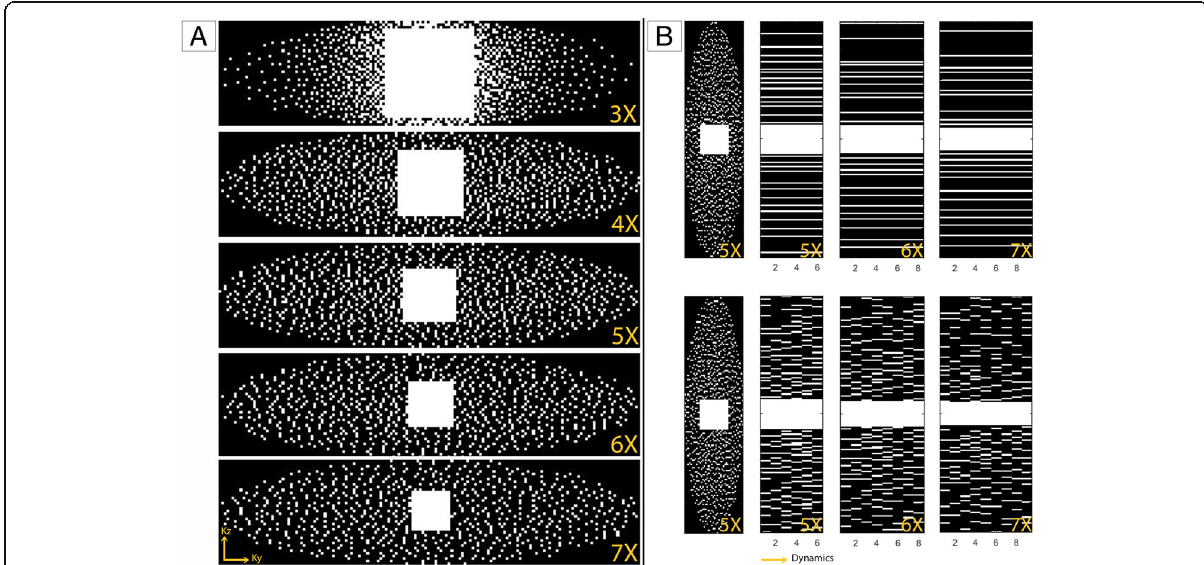
Fig. 1 a The non-uniform sampling patterns for an undersampling of 3×, 4×, 5×, 6×, and 7× used in the static experiment, consisting of a fully sampled auto calibration area in the centre of k-space and a Poisson disk distribution in the periphery. b Similar sampling patterns for an undersampling of 5×, 6×, and 7× used in the dynamic experiment. Top figures show an equal sampling pattern in time, bottom figures show a varying sampling pattern in time